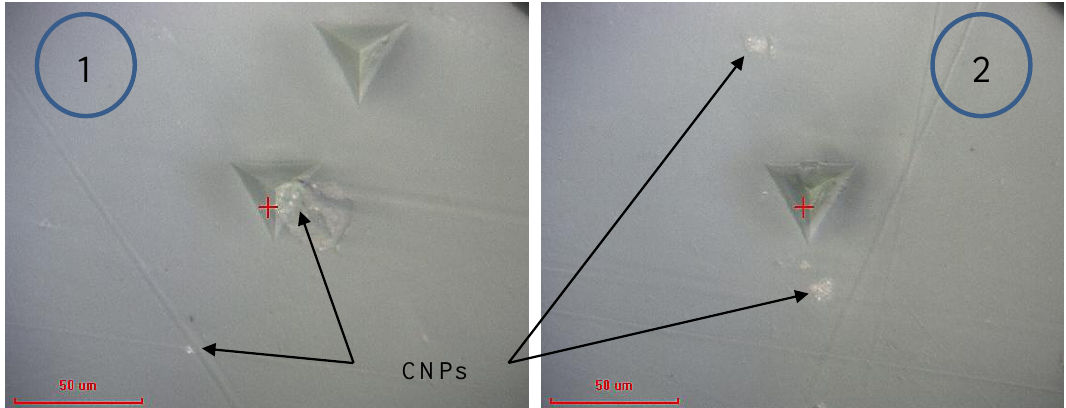
Figure 7. Micrographs of the indentation site of 1 wt % CNP filled epoxy for outliers 1 and 2 in Figure 6, representing indentation at or near CNP clusters.